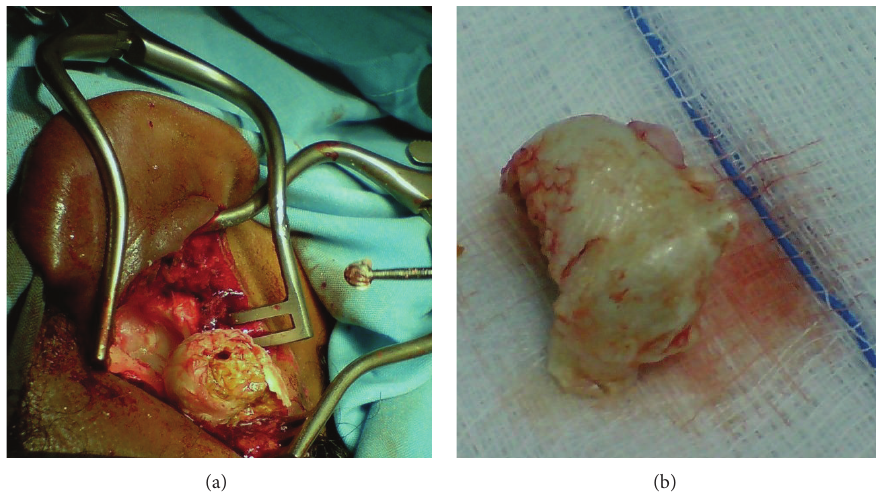
Figure 3: (a) shows the sac after delivery from the mastoid cavity before its removal. (b) shows the